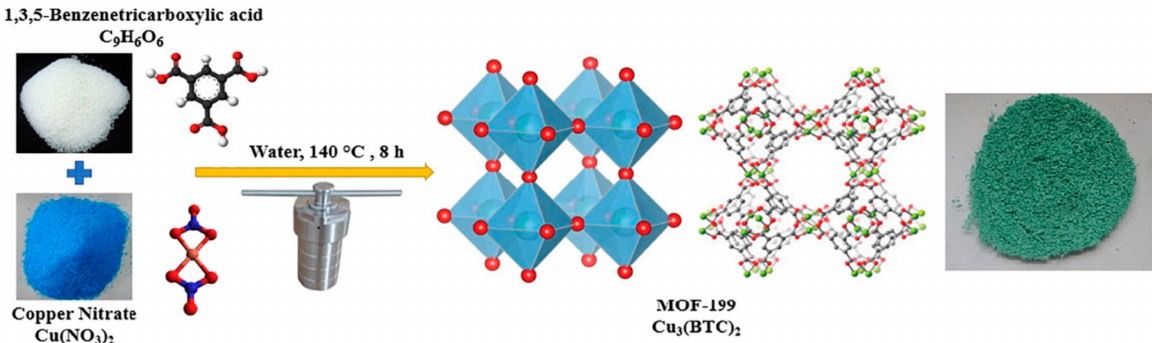
Figure 21. Schematic Procedure of HKUST-1 synthesis and structural elucidation. Reprinted with permission from Ref. [161]. Copyright 2019